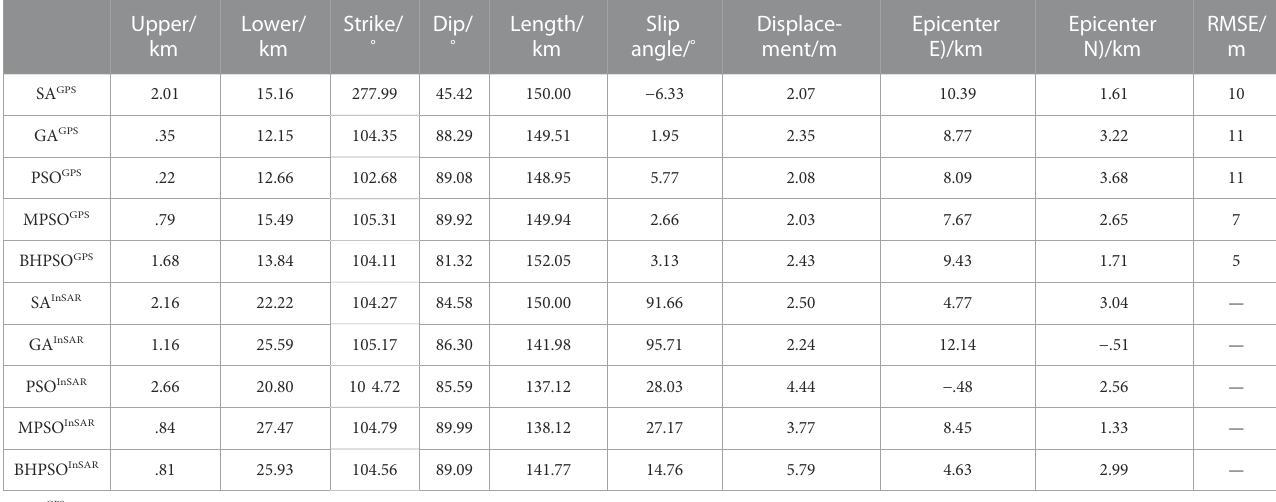
Upper/ Lower/ Strike/ Dip/ Length/ ° ° km km km